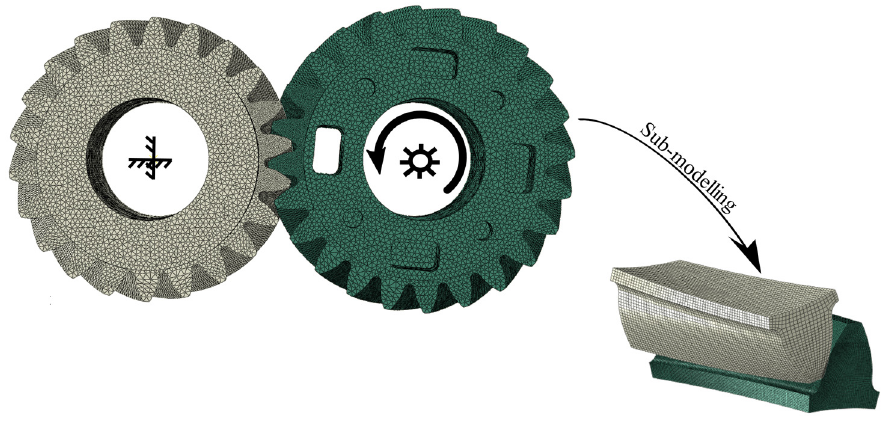
Figure 7. FE simulation procedure for the estimation of tooth root bending stress. The “ ” sym-bol represent an encastre while the “ ” one represent a locating-type constraint.